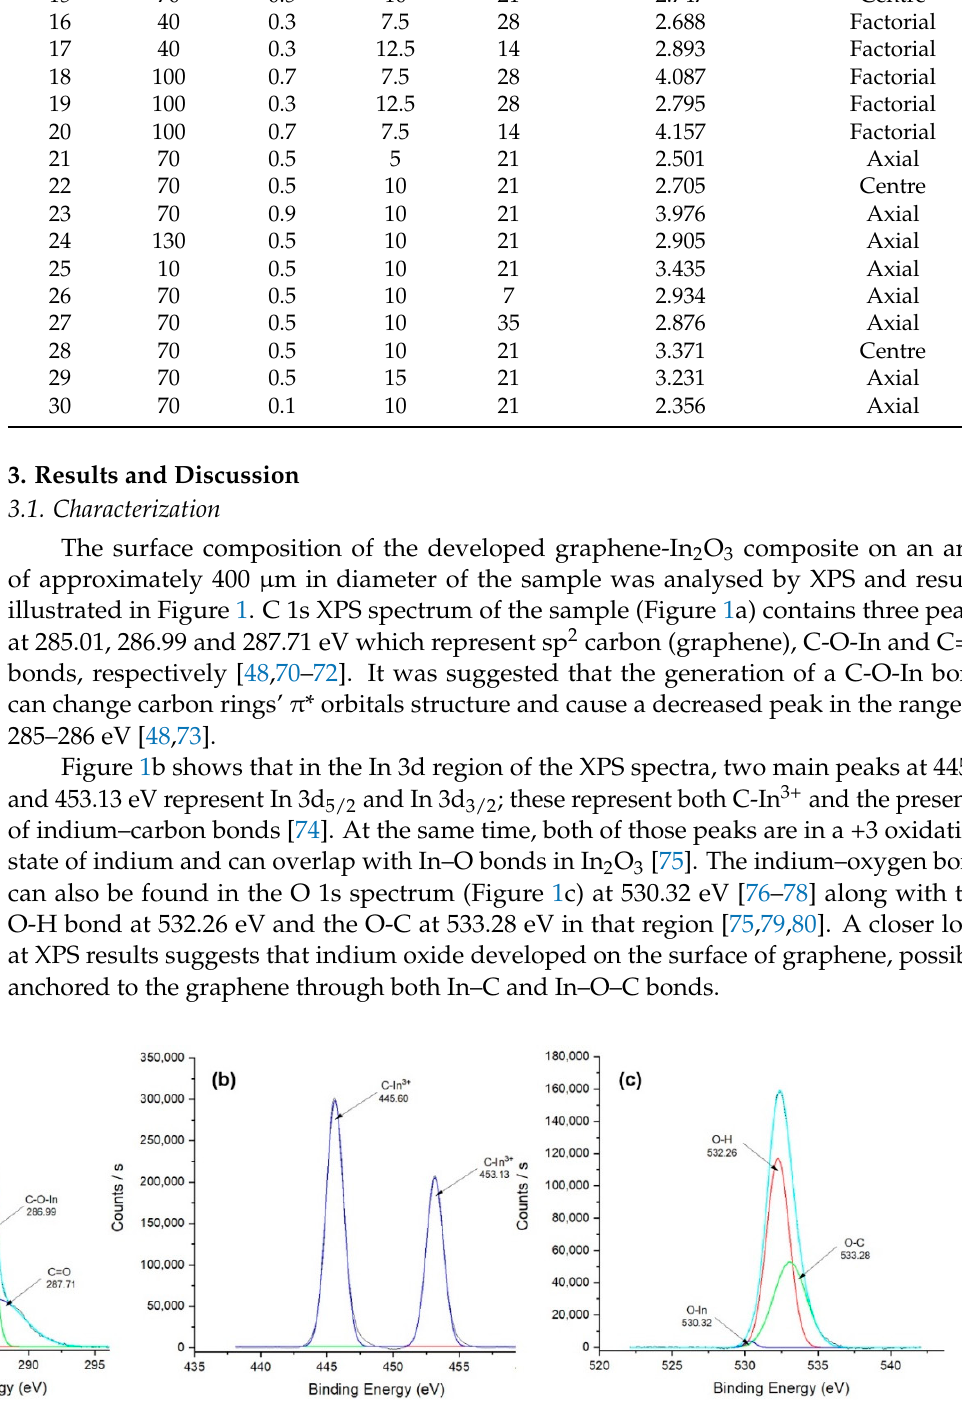
Figure 1. XPS spectra of ( a ) C 1s, ( b ) In 3d and ( c ) O 1s. A comparison of the FTIR spectrum of graphene oxide with reduced graphene